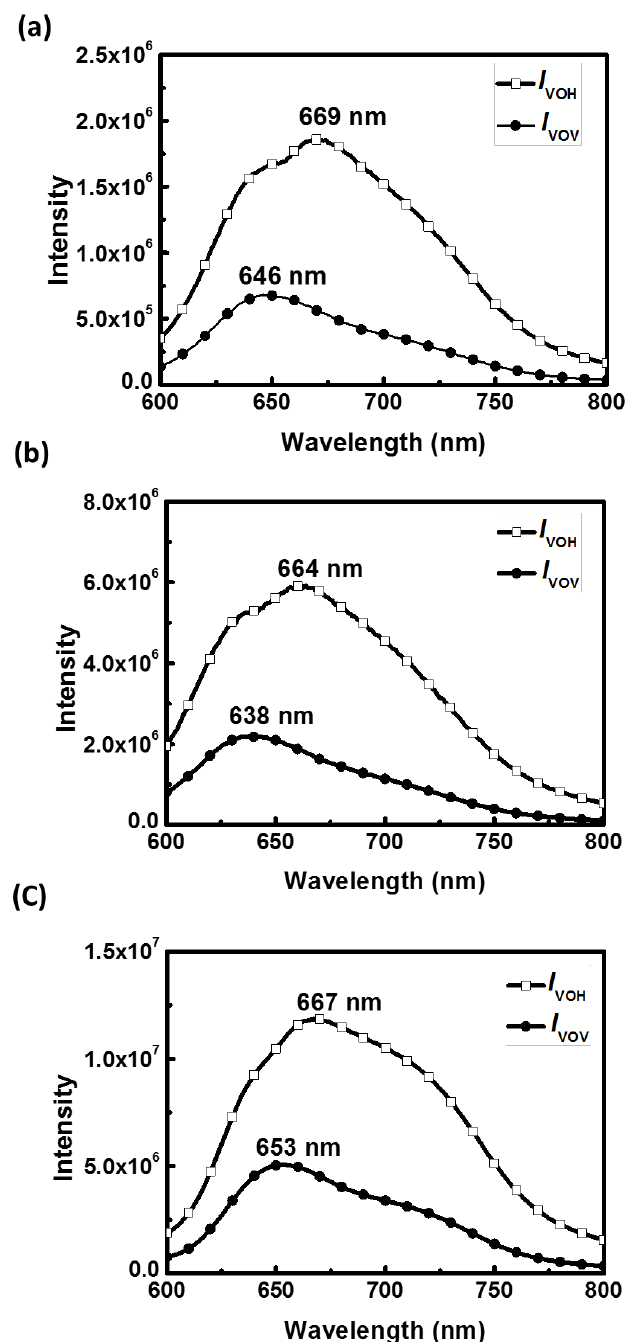
Figure 6. Polarized photoluminescence spectra of the aligned P3HT electrospun nanofibers, with an isotropic exciting light source and the corresponding emission collected for the perpendicular ( I VOH ) or parallel ( I VOV ) polarization with respect to the fiber axis for ( a ) CF; ( b ) CB and ( c ) TCB systems.